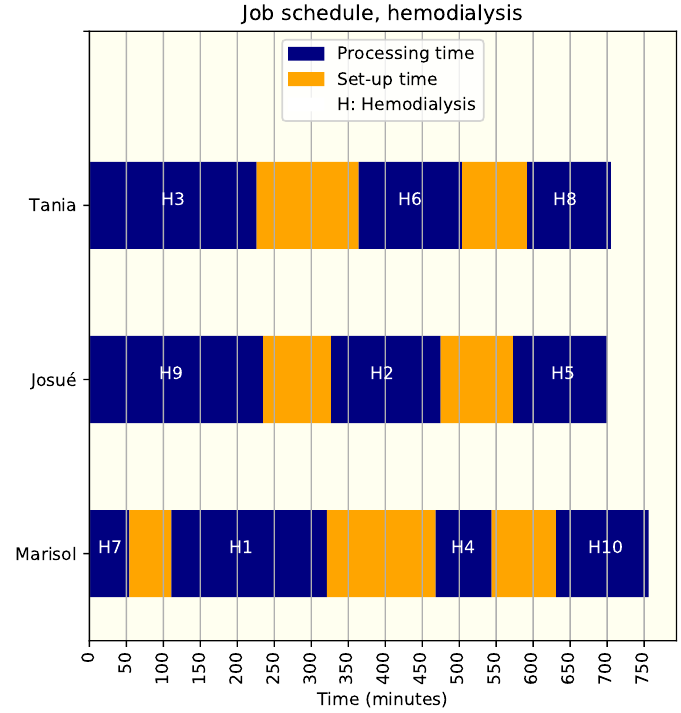
Figure A5. Hemodialisys schedule for the